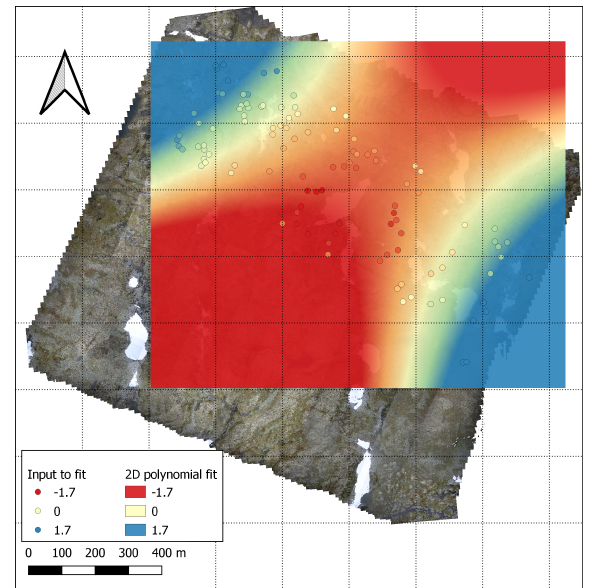
Figure 4. Map of the use case area with the fitted polynomial of ITERATION 3 as well as the points used in the fitting